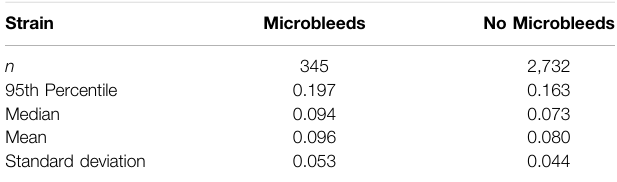
TABLE 1 | Summary statistics of strain per microbleed and non-microbleed grouped tracts. Strain Microbleeds